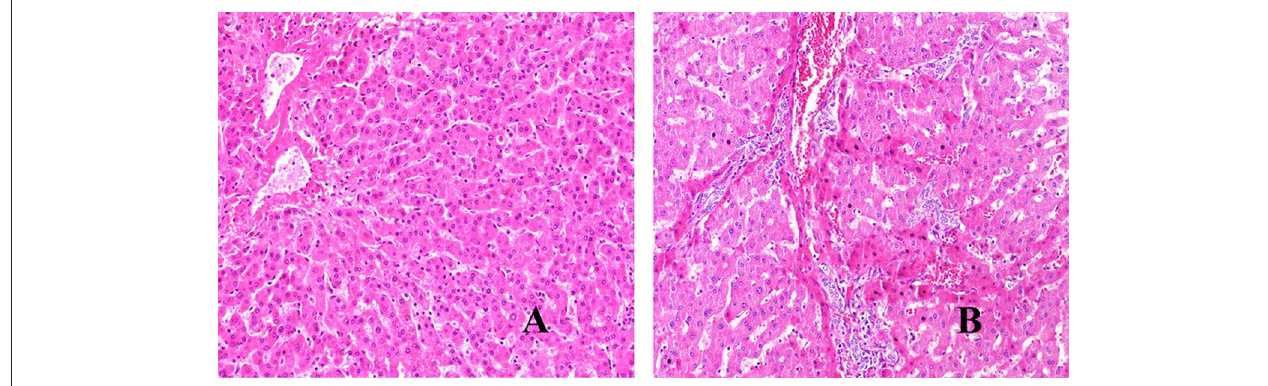
FIGURE 1 | H&E staining of liver lesions in patients with hepatic AE (magnification, × 200). (A) Distance group. (B) Close group.